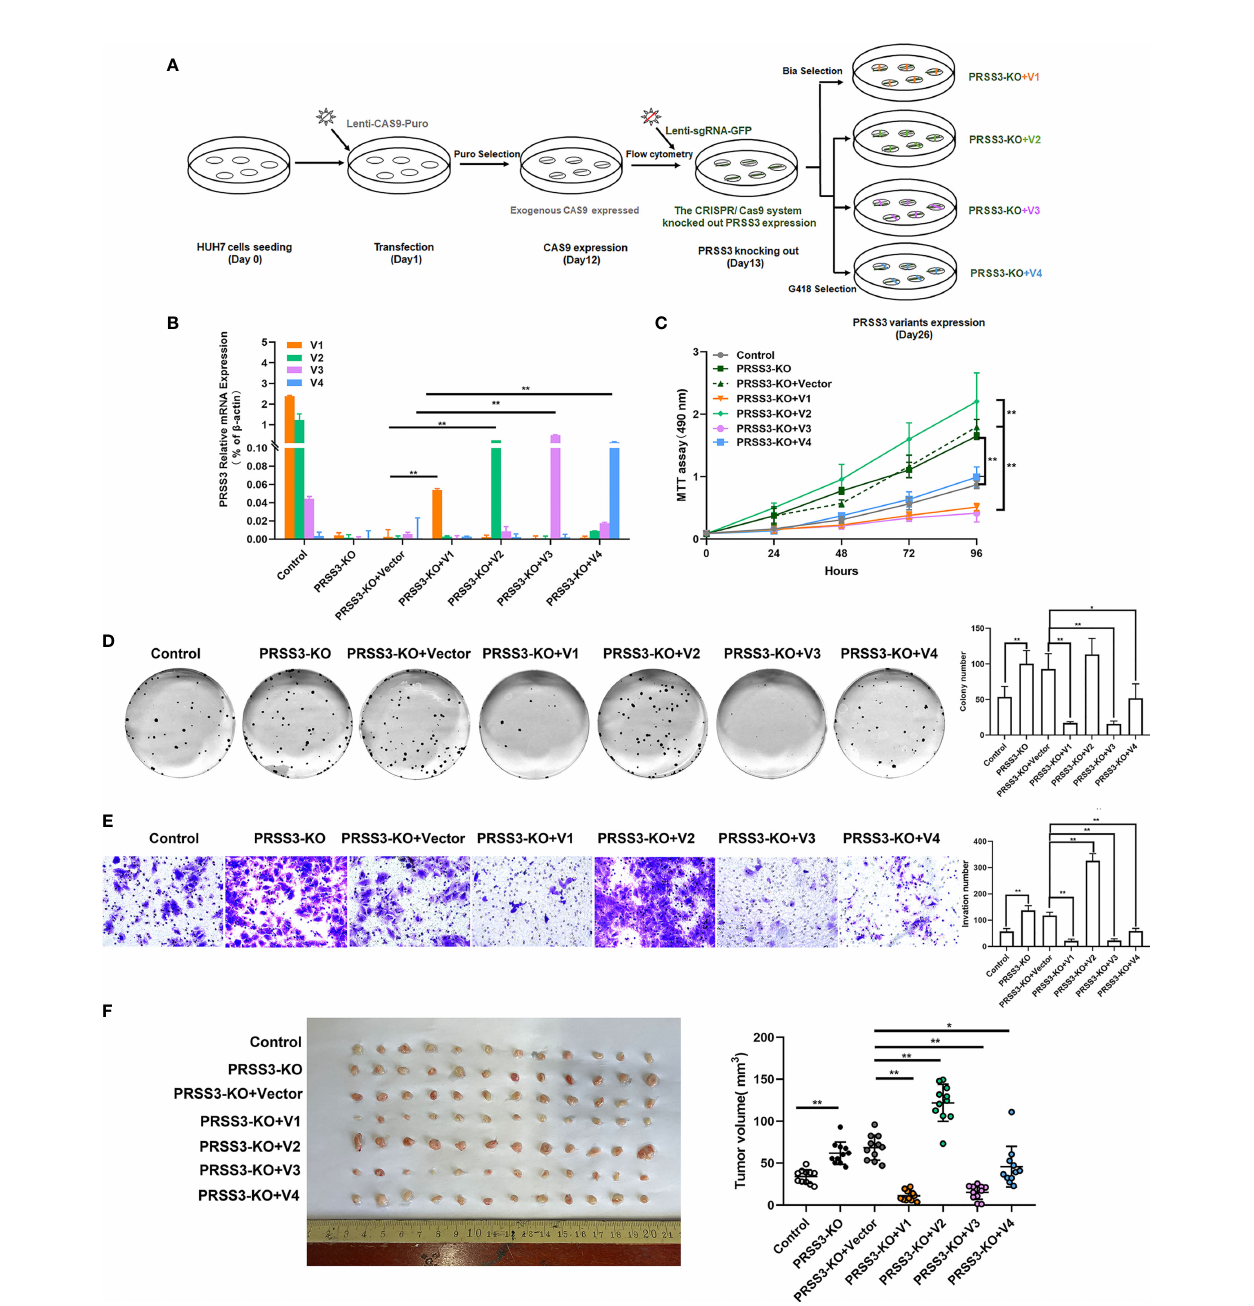
FIGURE 5 | Functional divergence of PRSS3 transcript variants in a gain- and loss-of-function cell model. (A) Schematic of the work fl ow for the construction of a cell model by endogenous deletion and then ectopic expression of the PRSS3 transcript in Huh7 cells ( PRSS3 KO+V cell model). Genomic deletion of PRSS3 transcripts by targeting the common exon 5-8 region in PRSS3 High Huh7 cells was performed using the CRISPR/Cas9 system, followed by transfection with PRSS3- V1 to PRSS3-V4 constructs ( PRSS3 KO+V1 to PRSS3 KO+V4 ) or vector control ( PRSS3 KO+C ). Puromycin (Puro), blasticidin (Bla) and geneticin (G418) were used for selection of the transduced cells. (B) RT – qPCR analysis of PRSS3 mRNA expression in the transfected cells. The relative mRNA expression of PRSS3 transcripts normalized to b -actin (Student ’ s t test). (C) MTT assays showed the viability of Huh7 cells (two ‐ tailed Student ’ s t ‐ test). (D) Colony formation of Huh7 cells for 2 weeks. Left panel: representative image; Right panel: The colony numbers counted. (E) Transwell invasion assay assessing the invasion capacity of Huh7 cells upon transfection. Left panel: representative images at 200× magni fi cation; right panel: quantitation of the invaded cells. One − way ANOVA with Tukey ’ s post-hoc test was calculated for the transfected cells compared with the vector control in (C – F) . * P < 0.05, ** P < 0.01, versus control. Data are presented as the mean ± SD of three independent experiments performed in triplicate. (F) Effects of PRSS-SVs on HCC tumorigenicity using the PRSS3 KO+V Huh7 cell model. Photographs (left panel) and tumor volumes (right panel) of dissected xenograft tumors from different groups of nude mice (n=12) after sacri fi ce. * P < 0.05, ** P < 0.01, one − way ANOVA with Tukey ’ s post hoc